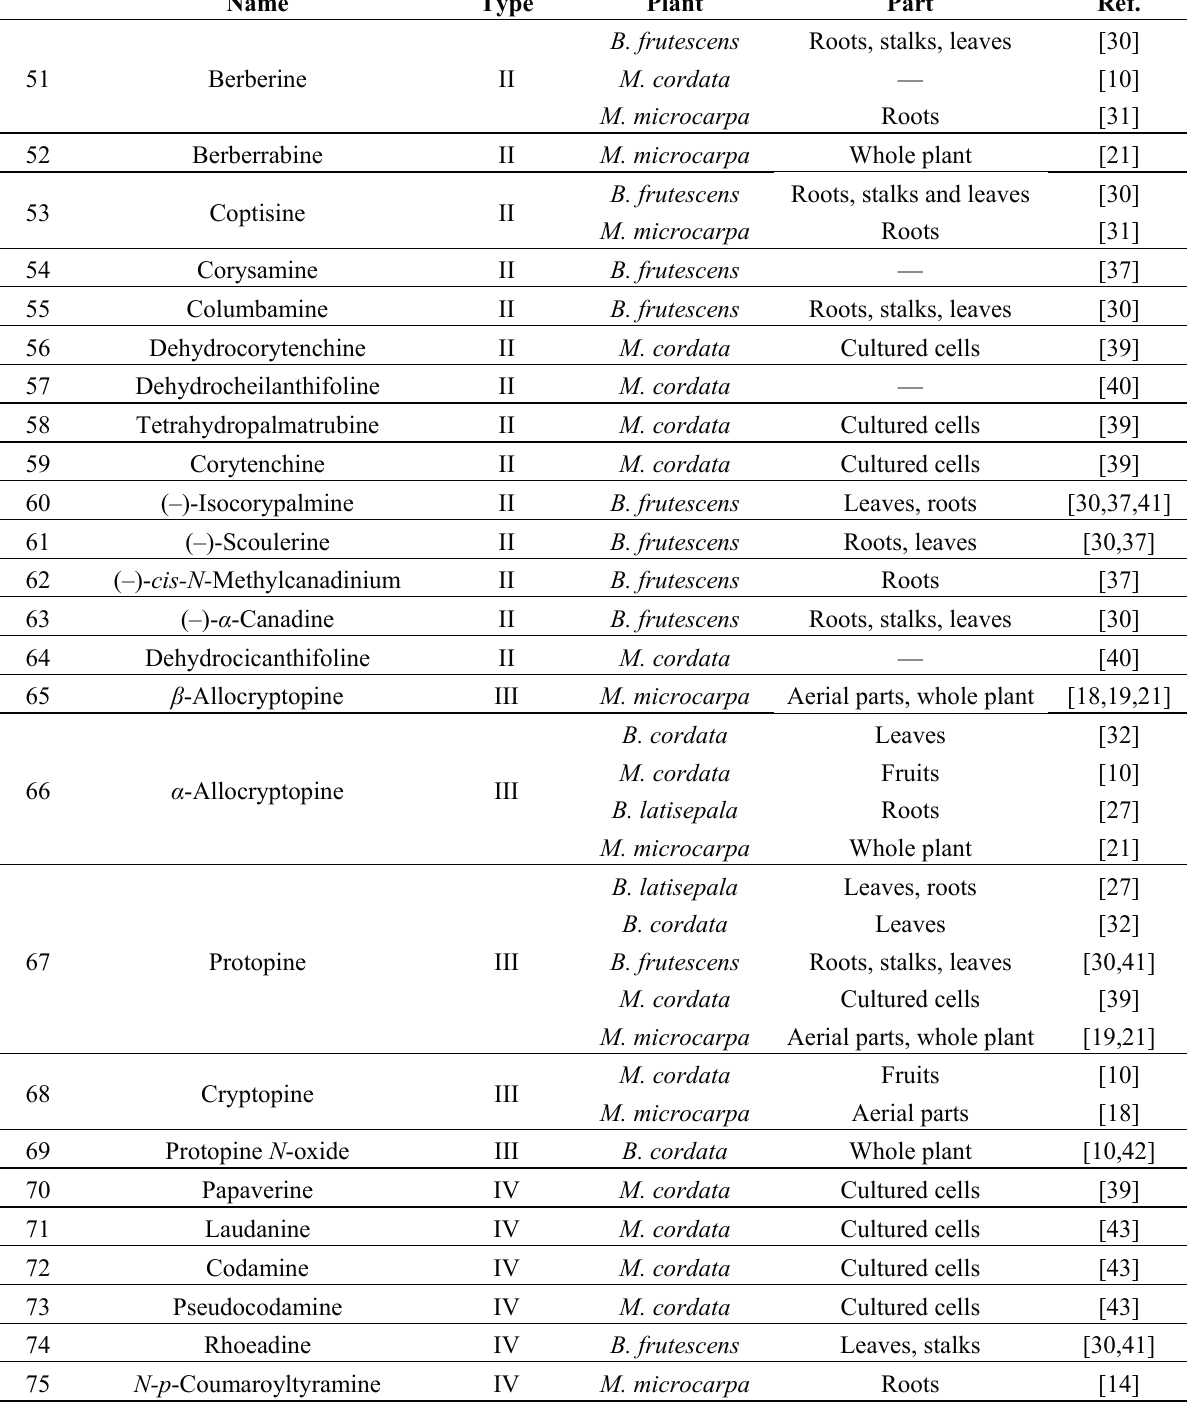
Table 2. Alkaloids isolated from